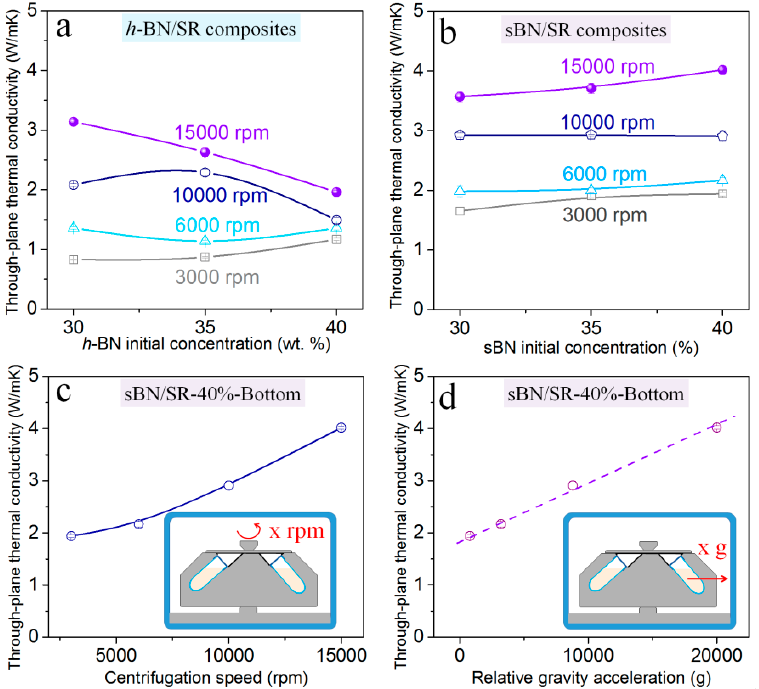
Figure 7. Factors affecting the thermal conductivity of BN/SR composites prepared with hypergravity treatments. ( a ) The effect of h ‐ BN initial concentration on the thermal conductivity of h ‐ BN/SR composites. ( b ) The effect of sBN initial concentration on the thermal conductivity of sBN/SR composites. ( c ) The effect of centrifugation speed and ( d ) relative acceleration on the thermal conductivity of sBN/SR ‐ 40% ‐ bottom composites prepared with hypergravity treatments.